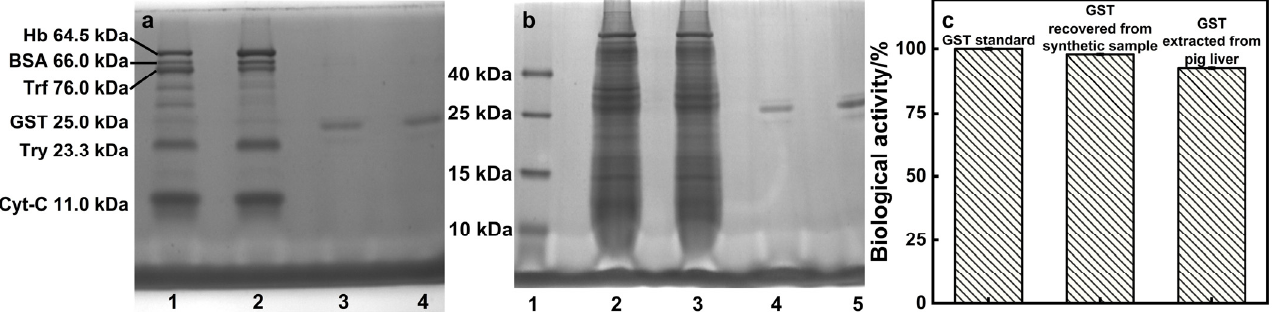
Figure 9. ( a ) SDS-PAGE assay results of the synthetic sample. Lane 1: synthetic sample; lane 2: synthetic sample after adsorption by the GPG composite; lane 3: solution recovered from the GPG composite; lane 4: GST standard (200 μ g mL − 1 ). ( b ) SDS-PAGE assay results of the pig liver sample. Lane 1: molecular weight standards (Marker in kDa); lane 2: 5-fold diluted pig liver sample without pretreatment; lane 3: 5-fold diluted pig liver sample after adsorption by the GPG composite; lane 4: GST-recovered solution from the GPG composite; lane 5: GST standard (200 μ g mL − 1 ). ( c ) Biological